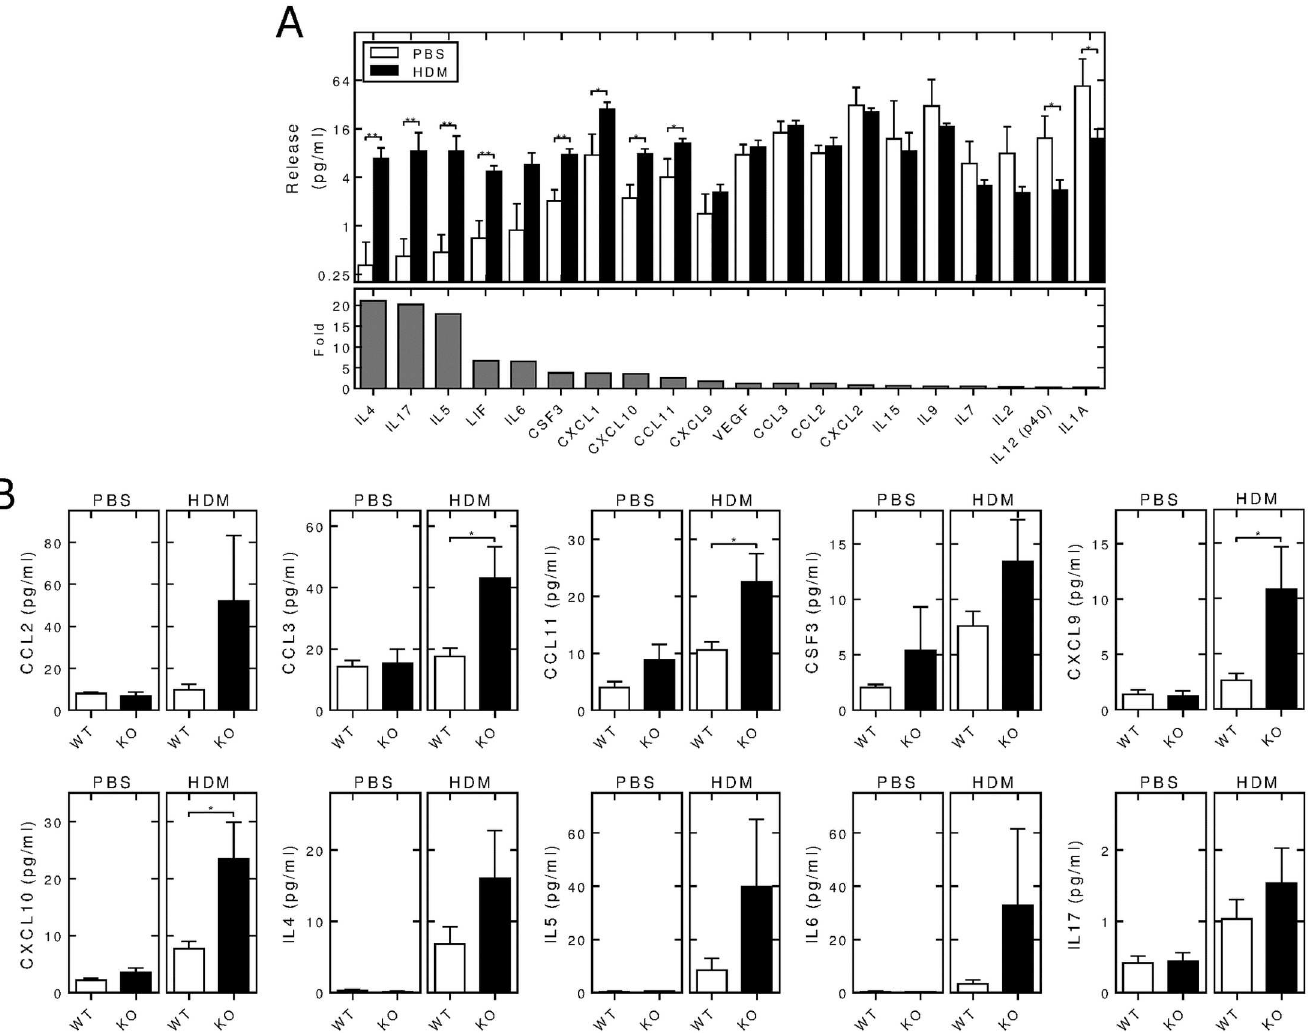
Fig 6. Effect of RGS2 deficiency on cytokines and chemokines in BAL fluid of PBS- and HDM-exposed animals. A, Wild type C57/Bl6mice were subjectedto i.n. instillationof PBS or HDM (25 μ g) 3 times/week for 3 weeks. BAL fluid supernatants were collected and cytokine/chemokine levels quantified using a mouse cytokine/chemokinemultiplexLuminexarray. Protein release (pg/ml) is shown (upper panel)rankedaccordingto the relative fold inductionby HDM (lower panel). Data ( N = 5 for PBS- and 8 for HDM-treated groups) are plotted as means ± SE. Significance was tested betweenPBS and HDM exposures by Mann Whitney U test. B, Wild type (WT) and Rgs2 -/- (KO) mice were subjectedto i . n . exposureto PBS (left panels) or HDM (25 μ g) (right panels) 3 times/week prior to Luminexanalysisas in A. Data ( N = 5 for PBS-treated wild type and Rgs2 -/- , N = 8 for HDM-treated wild type and 9 for Rgs2 -/- ) are plotted as means ± SE. Significance was tested betweenwild type and Rgs2 -/- groups by Mann Whitney U test. * P < 0.05, ** P <